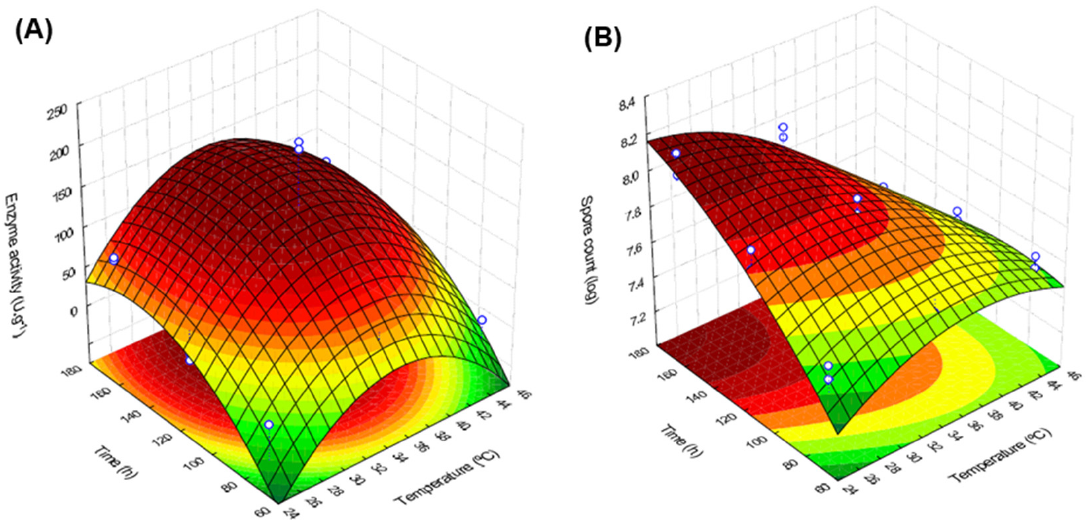
Figure 1. Response surface of the variables temperature and fermentation time on the response of enzyme activity ( A ) and spore count ( B ).